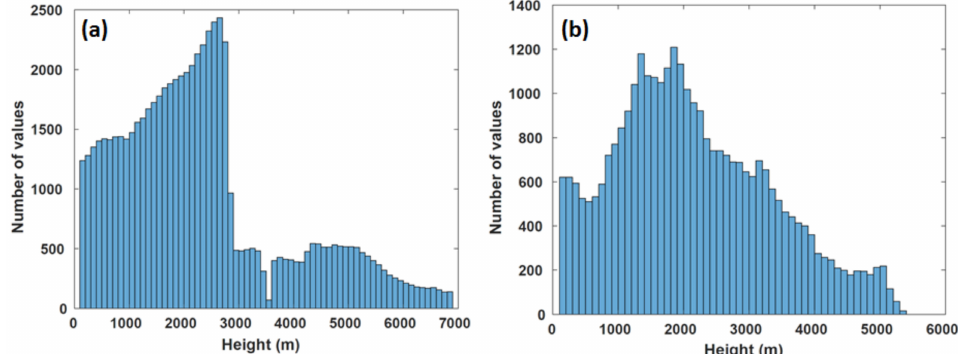
Figure 10. Histogram of ADWL measurements during the 2016 season ( a ) in the TC inner core environment and ( b ) during the transit to and from the